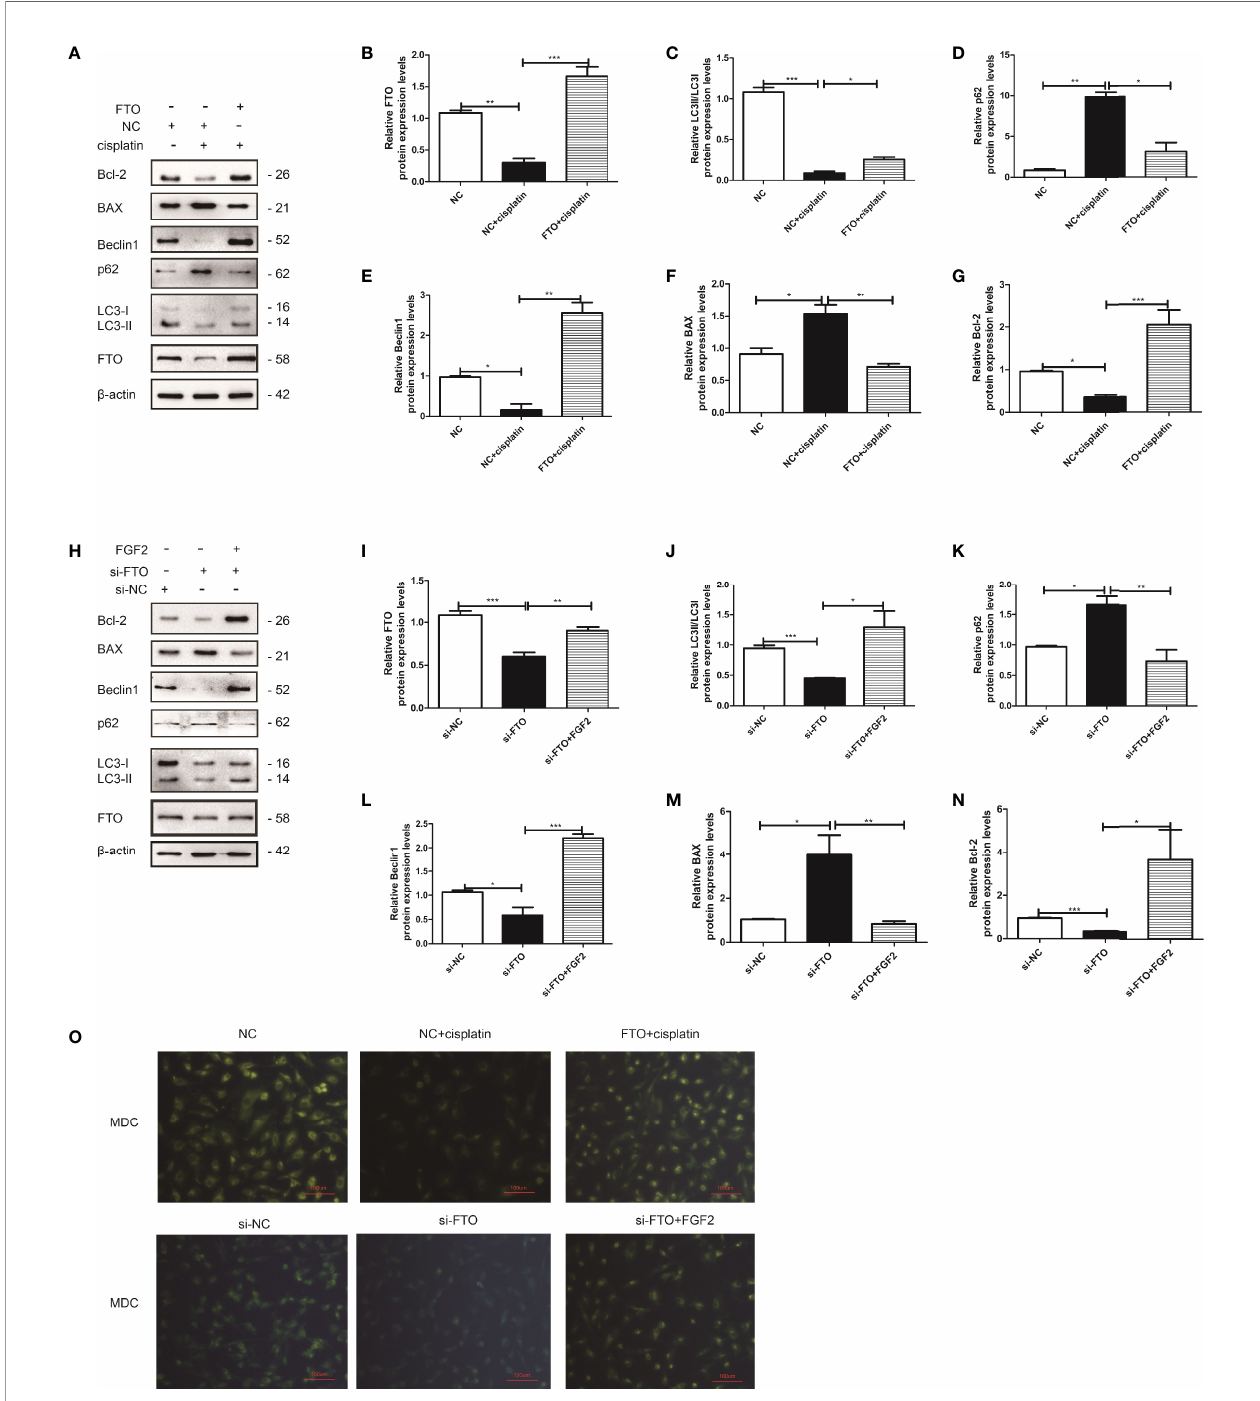
FIGURE 8 | FTO reversed injured KGN cell autophagy and decreased cell apoptosis. (A) Western blot and gain- and loss-of-function studies were conducted to explore the role of FTO in injured KGN cells. (B – G) Quantitative comparison of the different expression levels of FTO, Bcl-2, BAX, LC3, Beclin1, and p62. One-way ANOVA followed by Tukey ’ s multiple comparison test. The results were shown as mean ± SEM from three independent experiments ( a = 0.05, * P < 0.05, ** P < 0.01, *** P < 0.001). (H) Western blot and gain- and loss-of-function studies were conducted to show that FGF2 promoted injured KGN cell autophagy by regulating FTO expression. (I – N) Quantitative comparison of the different expression levels of FTO, Bcl-2, BAX, LC3, Beclin1, and p62. One-way ANOVA followed by Tukey ’ s multiple comparison test. The results were shown as mean ± SEM from three independent experiments ( a = 0.05, * P < 0.05, ** P < 0.01, *** P < 0.001). (O) Representative images of KGN cells were treated with NC, NC plus cisplatin, and FTO plus cisplatin or si-NC, si-FTO, and si-FTO plus FGF2, and then cells were stained with MDC (scale bar: 100 m